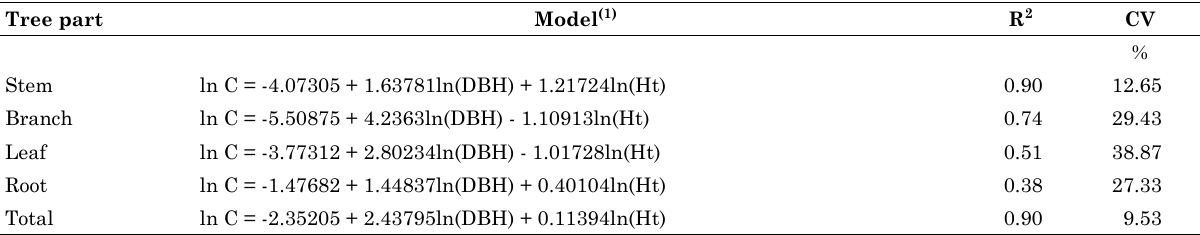
Table 2. Allometric models for estimating the carbon stocks in different tree biomass components tree